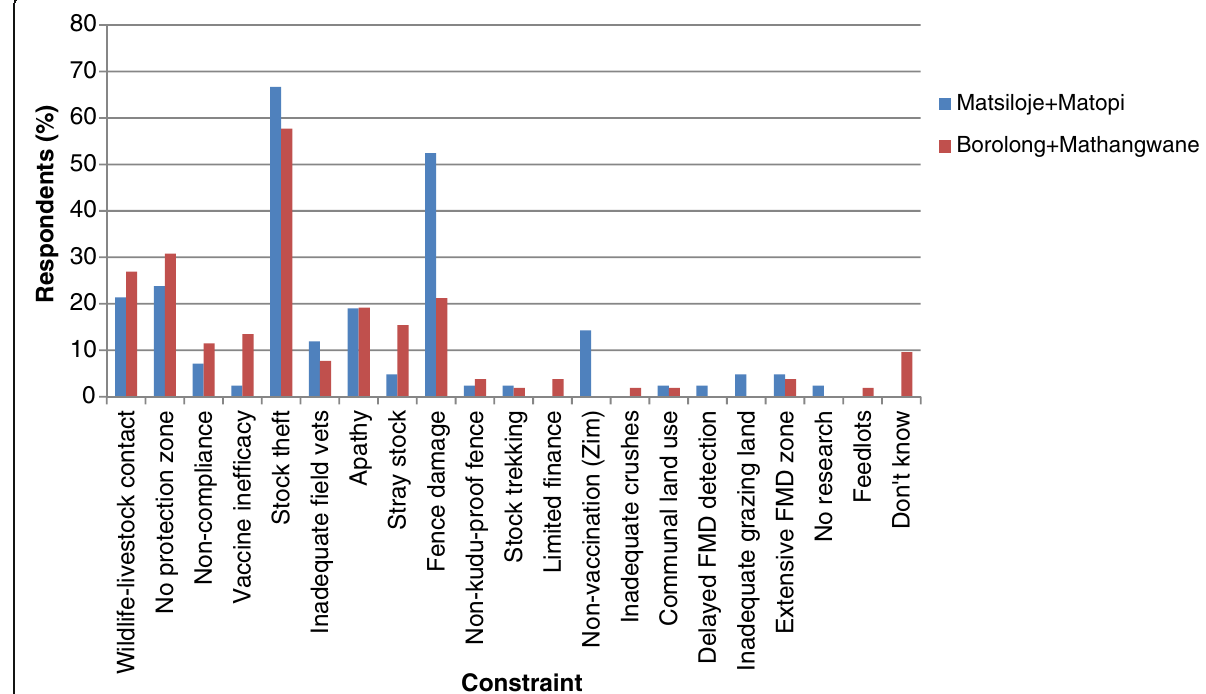
Fig. 1 Constraints identified in the control of foot and mouth disease in the study